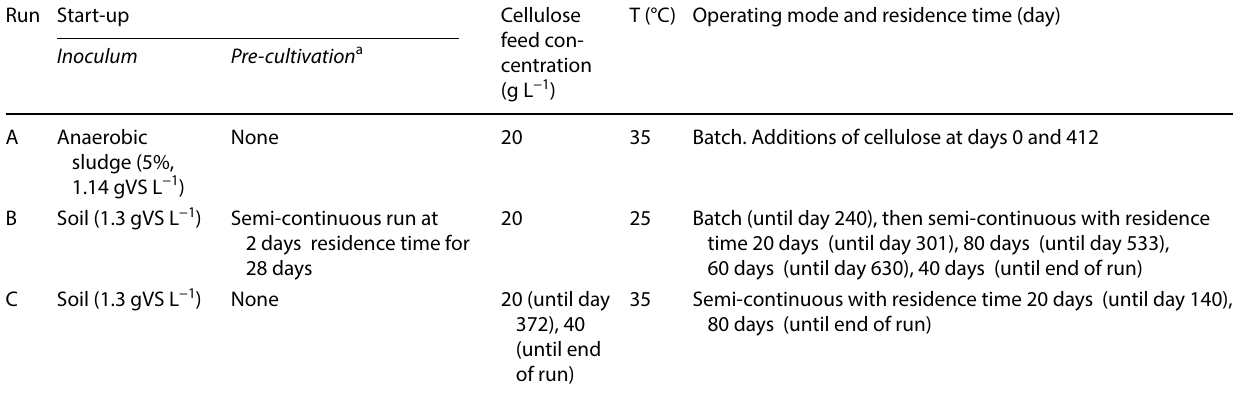
a Pre-cultivation refers to the period before the start of the data reported in Figs. 2, 3